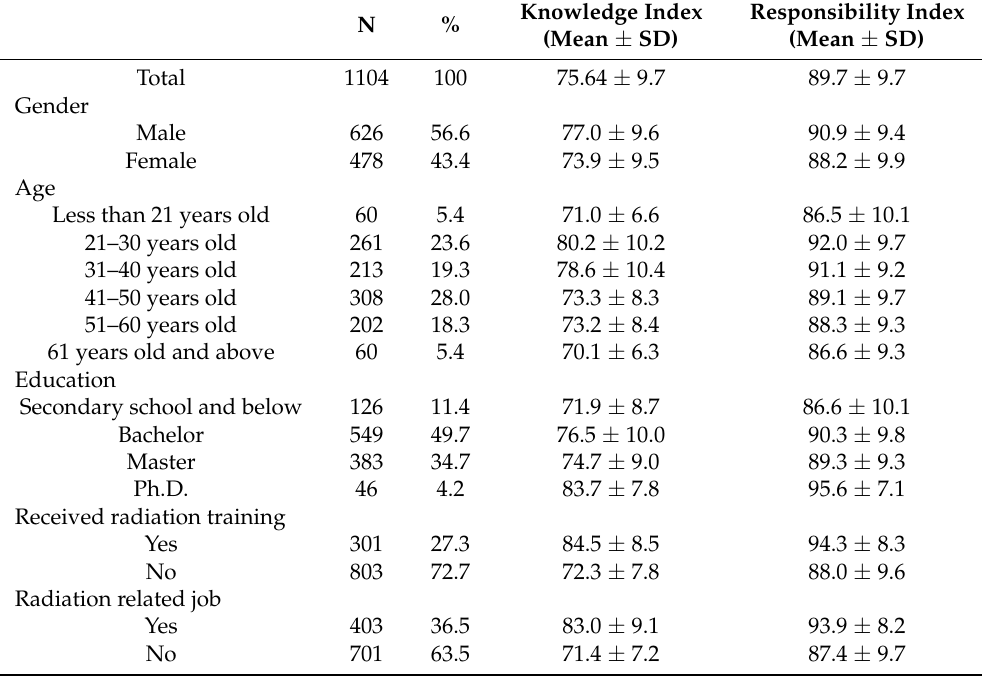
Table 1. The results of two index corresponded to the demographic characteristics of the respondents participating in the